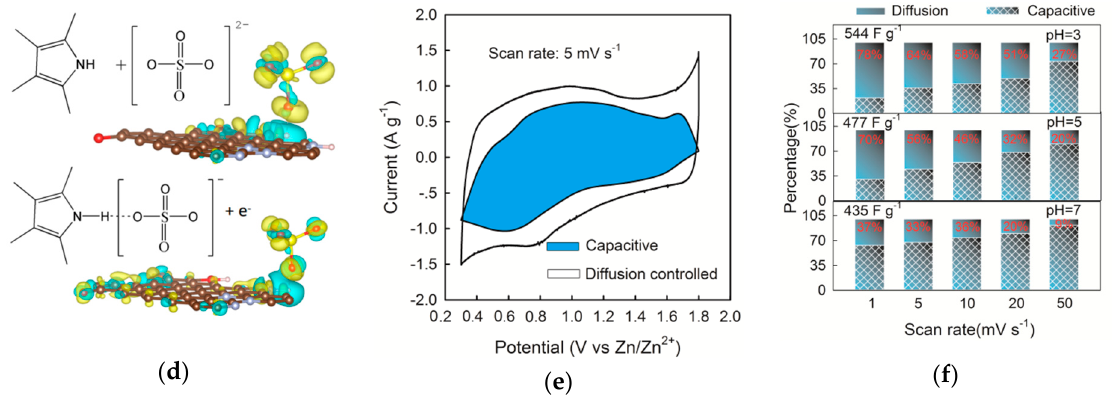
Figure 4. ( a ) Cyclic voltammetry (CV) curves of the six samples obtained using the carbon positive electrode as working electrode, and the pure Zn foil as both the counter and reference electrodes at 5 mV s − 1 and 0.3 to 1.8 V vs. Zn / Zn + . ( b ) Comparison between the changes of functions contents and the change of the average capacitances at 0.1 A g − 1 for the five samples in the Zn-ion hybrid supercapacitors (SCs) with aqueous electrolyte. DFT simulation of the proton transfer process on the –OH group ( c ) and –NH group ( d ) from the initial adsorption state to the final relaxed state. ( e ) Separation of the capacitive currents ( k 1 v , blue shadow area) and di ff usion currents ( k 2 v 1 / 2 , blank area) for the FACs positive electrode in the Zn-ion hybrid SCs with aqueous electrolyte at the scan rate of 5 mV s − 1 . ( f ) The di ff usion and capacitive contribution ratio in the total intercalated charge as a function of sweet rates during CV processes for three SCs samples with pH values of 3, 5, and